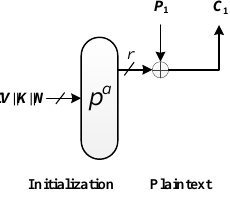
Figure 2: Objective Procedure of